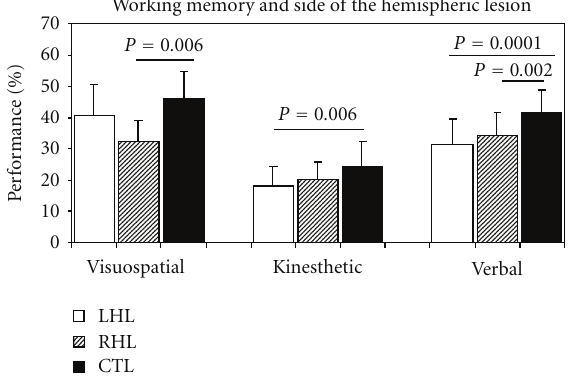
Figure 4: Mean (1SD) visuospatial, kinesthetic and verbal working memory performance for the sub-groups of patients with a left (LHL) and a right (RHL) hemispheric lesion and for the control subjects